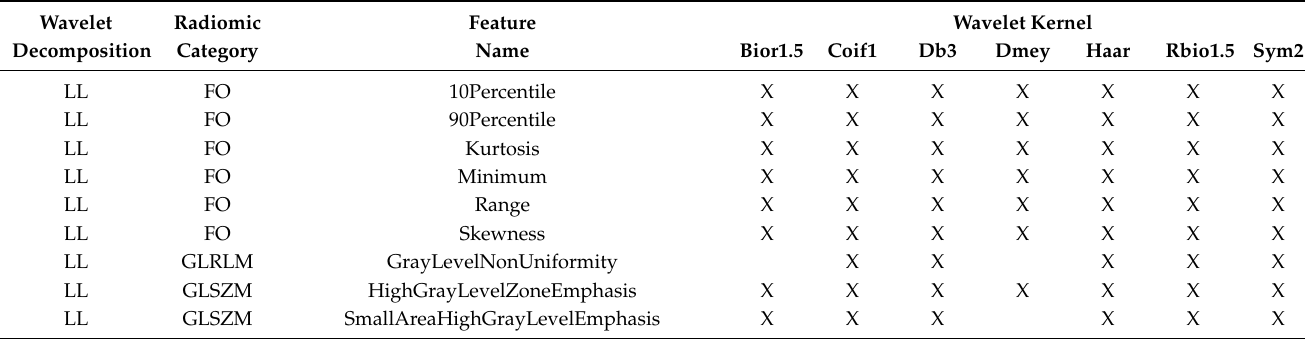
Table 2. Complete lists of radiomic features remaining after the preprocessing step for each of the wavelet kernels